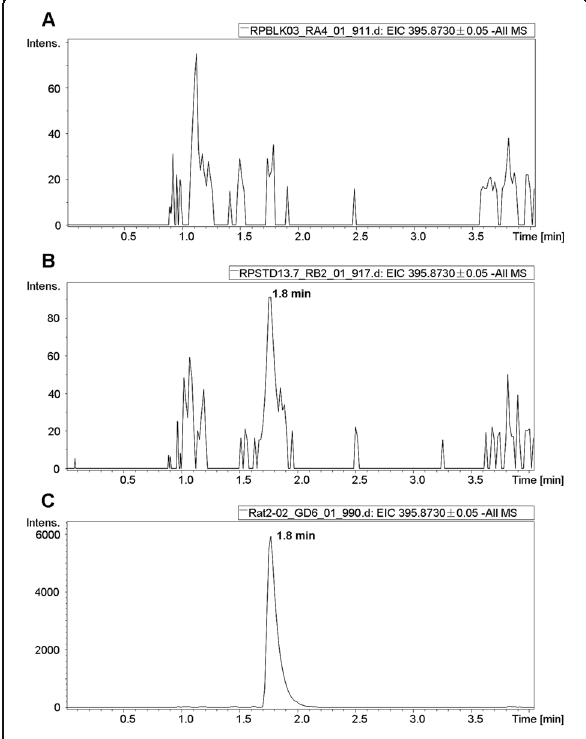
Fig. 2 Typical MS1 chromatograms of BTH in a blank plasma, b LOD sample, and c real subject sample of 0.083 h after intravenous injection of 2 mg/kg dose of bromophenol-thiosemicarbazone